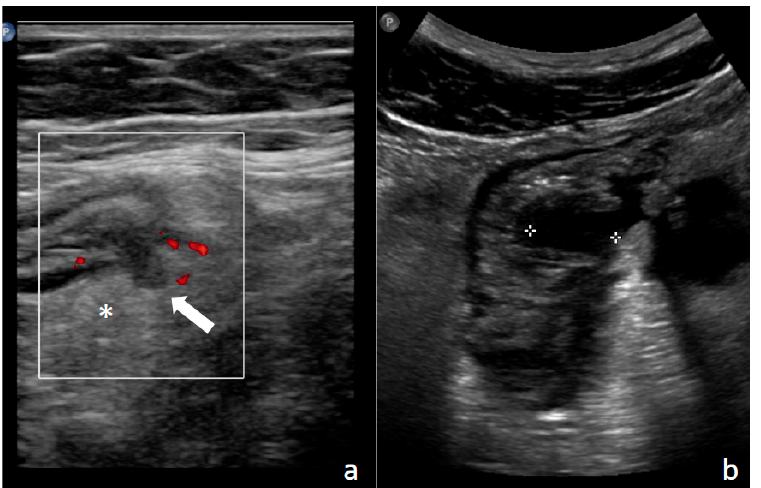
Figure 2. Diverticulitis on ultrasound imaging: ( a ) in the site of tenderness descending colon show a diverticulum as a bowel outpouching (arrow) surrounded by echogenic and non-compressible fat (*) with mild hypervascularization on power Doppler study; ( b ) a localized abscess appears as a hypoechoic fluid collection (between calipers) inside the thickened colonic wall.